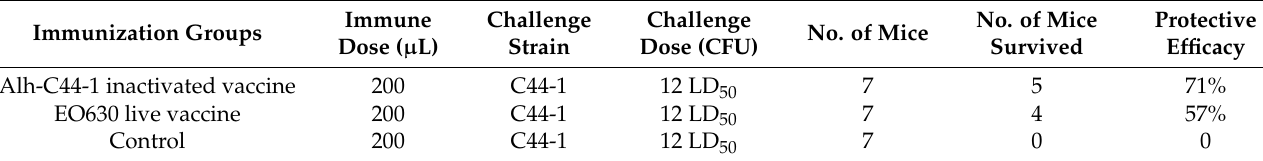
Figure 1. IgG antibody titers against P. multocida after vaccination. Blood samples were collected before each immunization (days 0 and 21) and before challenge (day 35). ‘C44-1 vaccine’ indicates mice inoculated with the inactivated Alh–C44-1 vaccine on days 21 and 35. ‘EO630 vaccine’ indicates mice inoculated with the live EO630 vaccine on days 21 and 35. ‘PBS control’ indicates mice inoculated with sterile PBS buffer on days 21 and 35. The P. multocida -specific antibody titers in the experimental and control groups were measured with an indirect ELISA and recorded at OD 450 . The error bars represent the SE. ** p < 0.01; * p < 0.05; ns, not significant. Table 1. Immune protection afforded by traditional vaccines against P. multocida serogroup B strain.